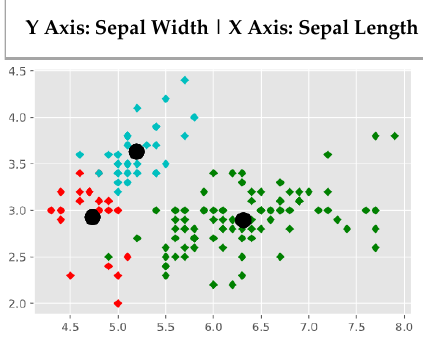
Figure 9. Incorrectly modeled Iris clusters.